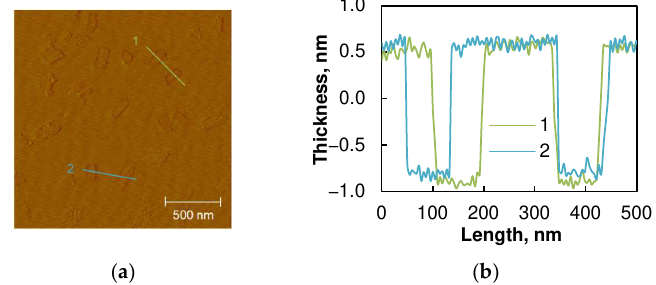
Figure 3. The AFM image ( a ) and height profiles ( b ) of delaminated nanoclay.